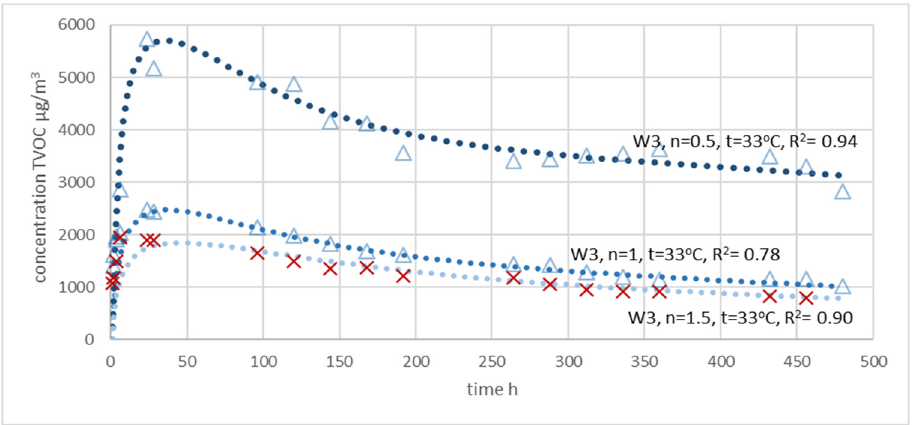
Figure 9. The TVOC emission profiles from W3 sandwich floor systems (test by 480 h) for three air changes rates ( n =0.5 h − 1 , 1 h − 1 and 1.5 h − 1 ) at 33 °C and RH=80% in the emission test chamber. (W3 sample is a system made of: polyurethane solvent primer, polymer–cement waterproofing and epoxy adhesive (see Table 3); significant VOCs compounds for these products are provided in Table 1).